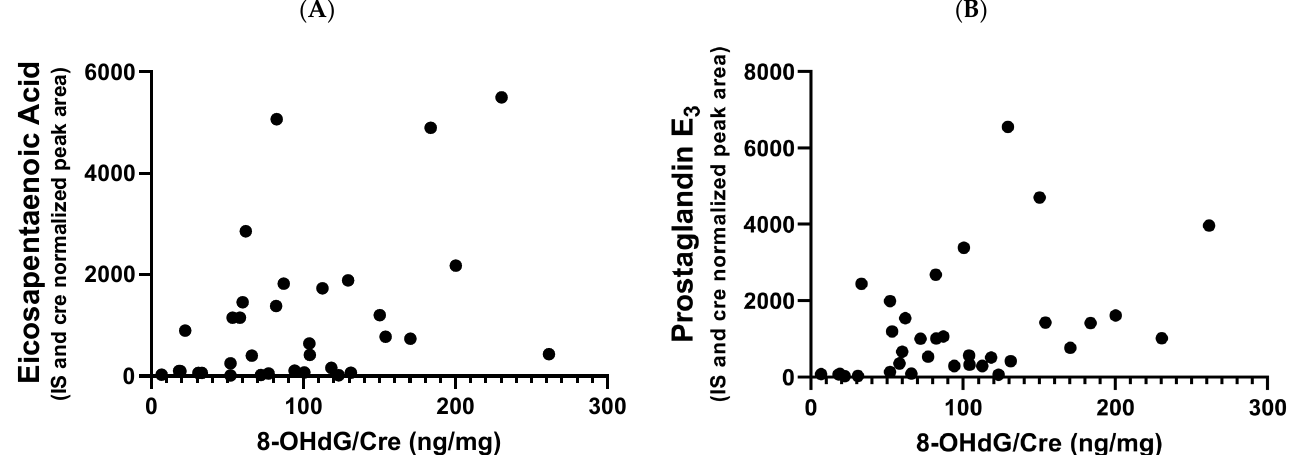
Figure 4. Correlation between 8-OHdG and urinary metabolite levels. ( A ) PGE 3 level (r = 0.4625) and ( B ) EPA level (r = 0.4112). Data on two time points for 17 patients were plotted. 8-OHdG, 8-hydroxy-2 ′ -deoxyguanosine levels, an oxidative stress marker.